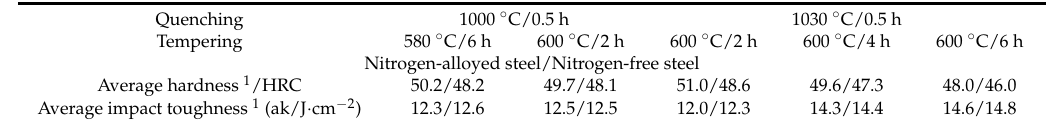
Table 2. Mechanical parameters after